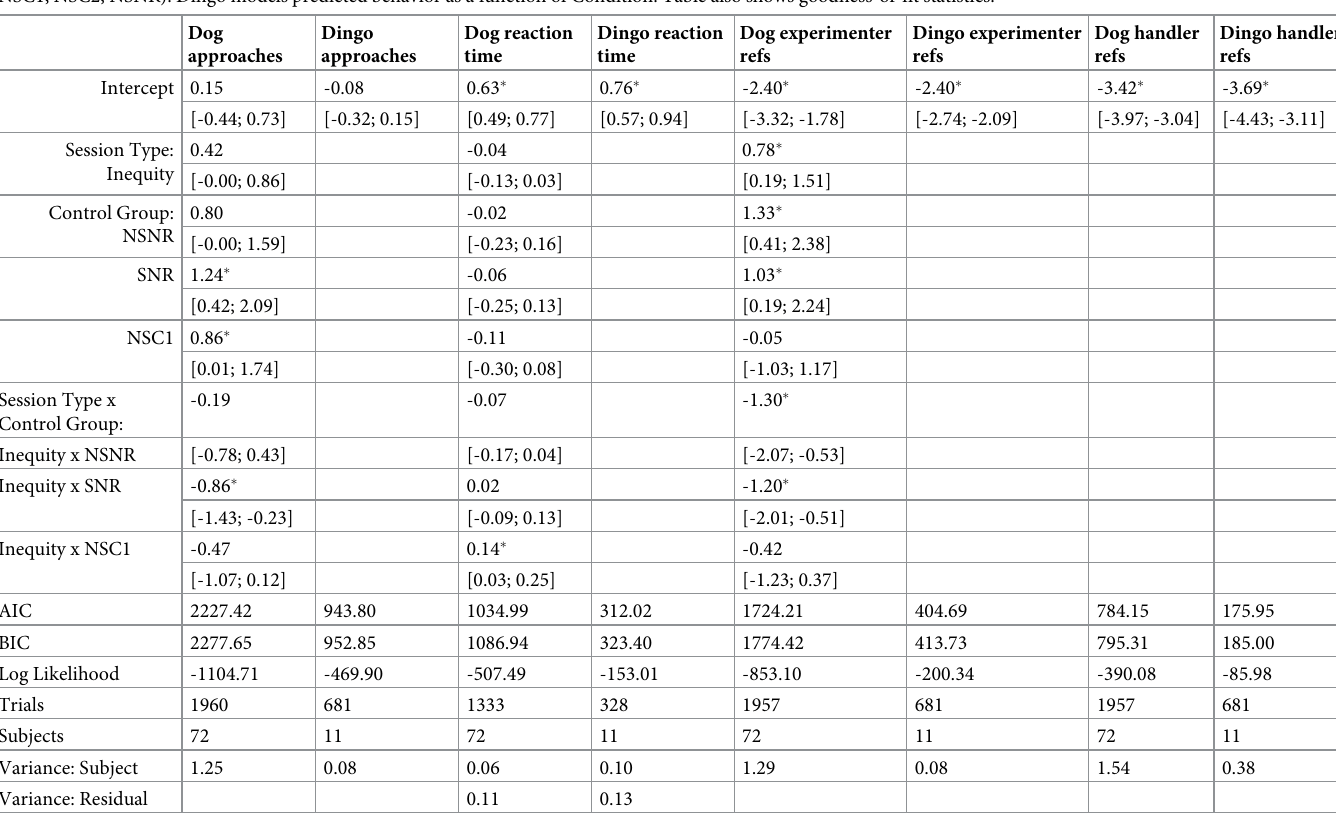
Table 3. Estimates and bootstrapped confidence intervals (N = 500 simulations) of fixed effects in minimal mixed models predicting approach behavior, reaction time and referencing behavior. Domestic dogs were tested in a between-subject design in which each dog received one session where condition was Inequity and one ses- sion where condition was one of four controls. Domestic dog models predicted behavior as a function of Control Group (SNR, NSC1, NSC2, NSNR; baseline = NSC2) and Session Type (Control vs. Inequity; baseline = Control). Dingoes were tested in a within-subject design in which all subjects received all five conditions (Inequity, SNR, NSC1, NSC2, NSNR). Dingo models predicted behavior as a function of Condition. Table also shows goodness-of-fit